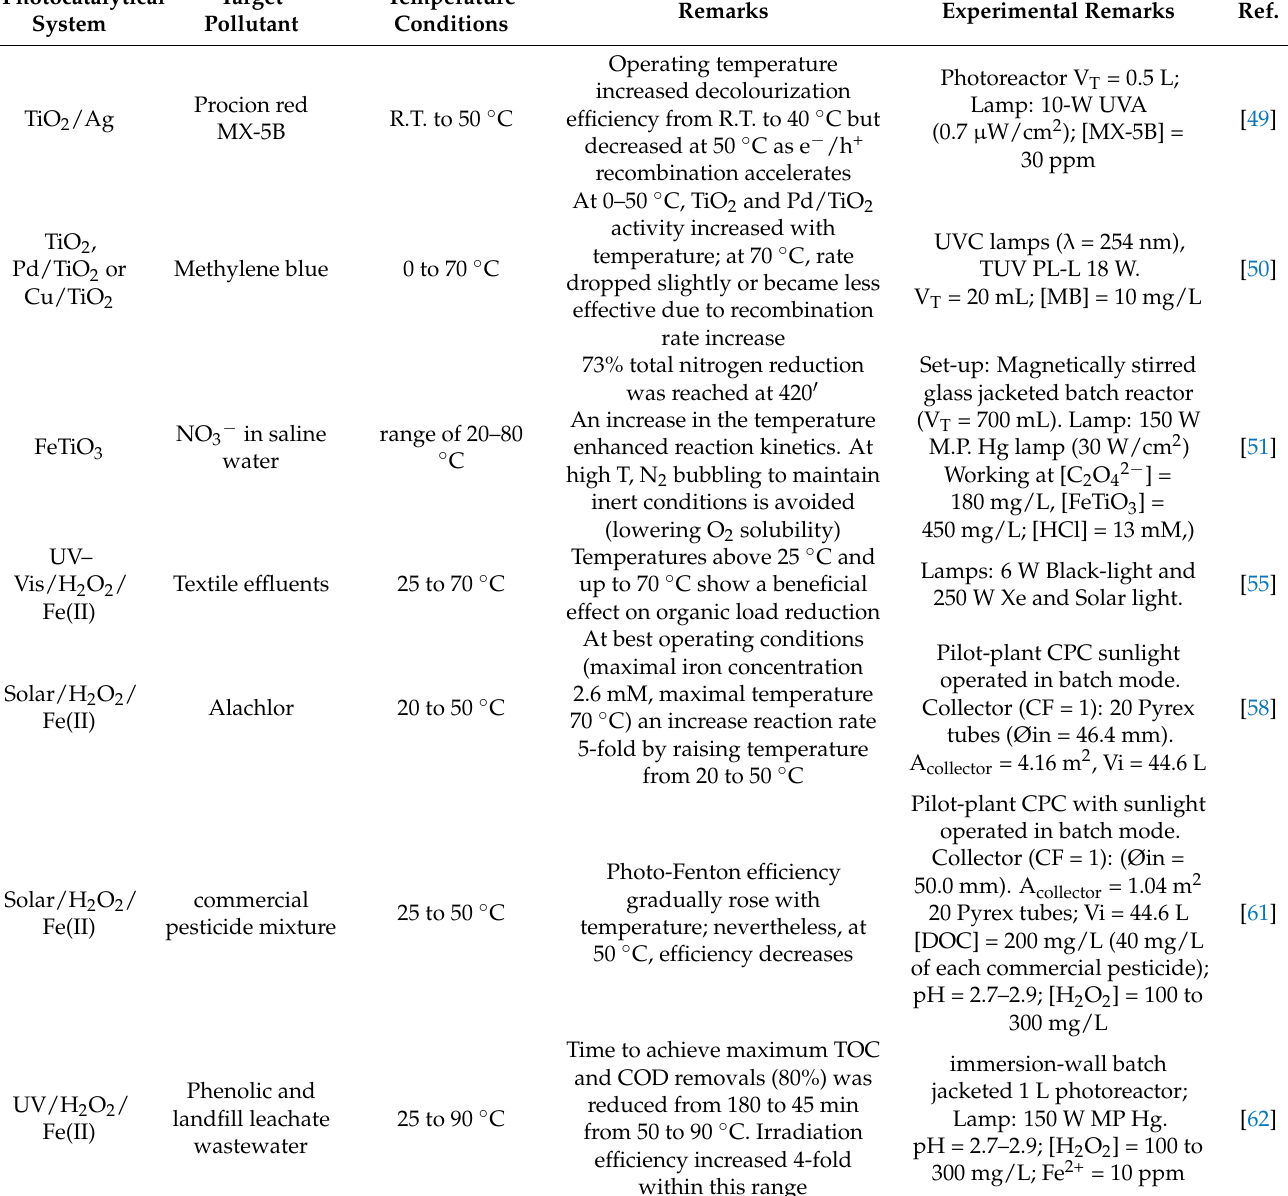
Table 3. Intensification of UV-AOPs by temperature